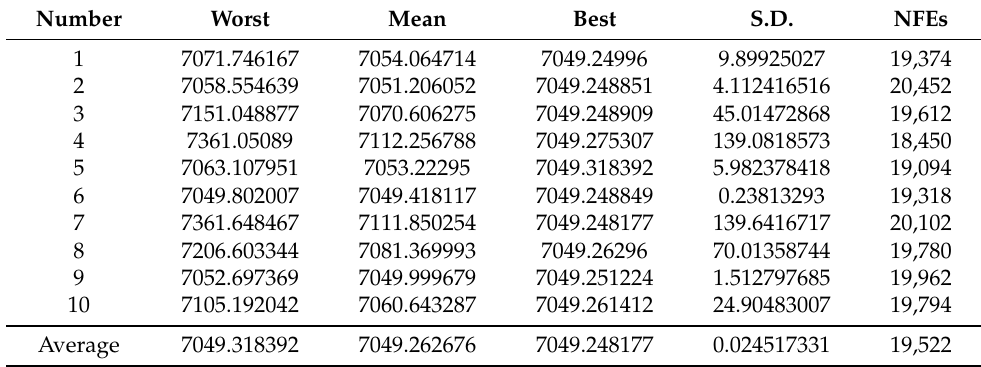
Table 11. Statistical results for G10 by ASIM.